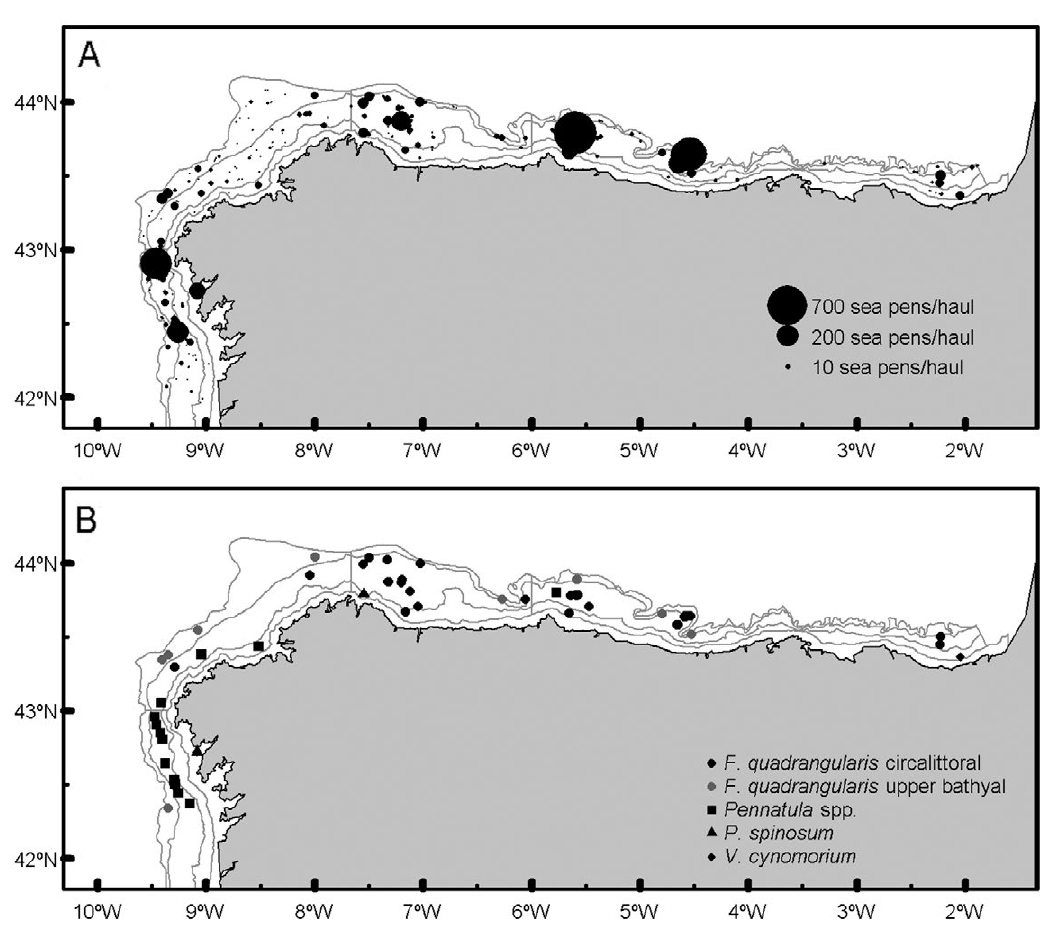
Fig. 3. – Distribution of sea pens (A) and of the aggregations (B) in the study